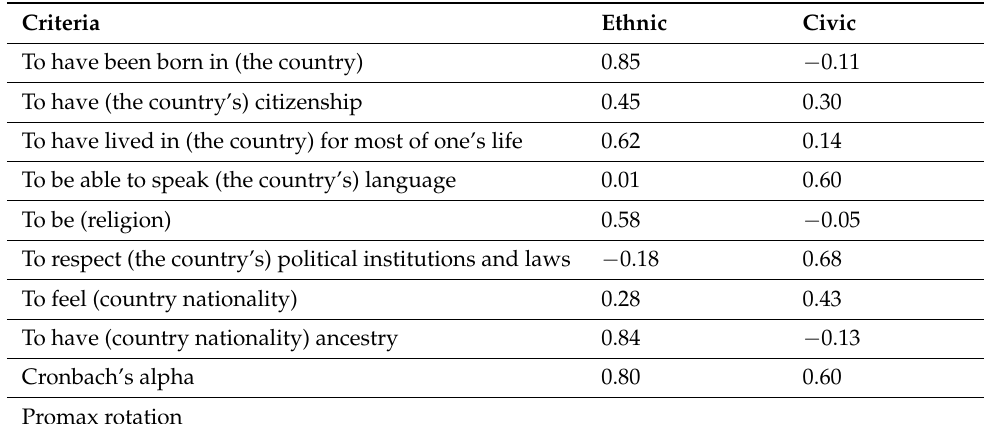
Table 2. Factor loadings for EFA. ISSP 2003 and 2013 criteria for being truly